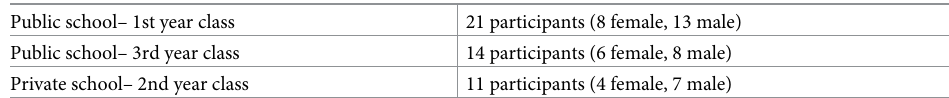
Table 2. Composition of the three focus groups (n =